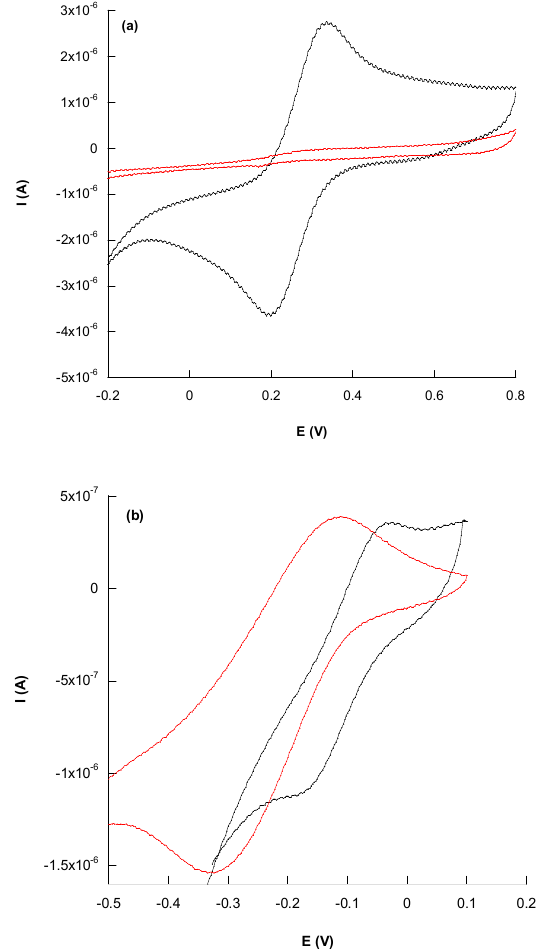
Figure 3. Cyclic voltammograms of 1.1 mM K 3 [Fe(CN) 6 ( a ) and 1.1 mM [Ru(NH 3 ) 6 ]Cl 3 ( b ) on Au (black line) and Au/KLNPs (red line). Experimental conditions: PBS buffer (pH 7.4), ν = 100 mV s − 1 .